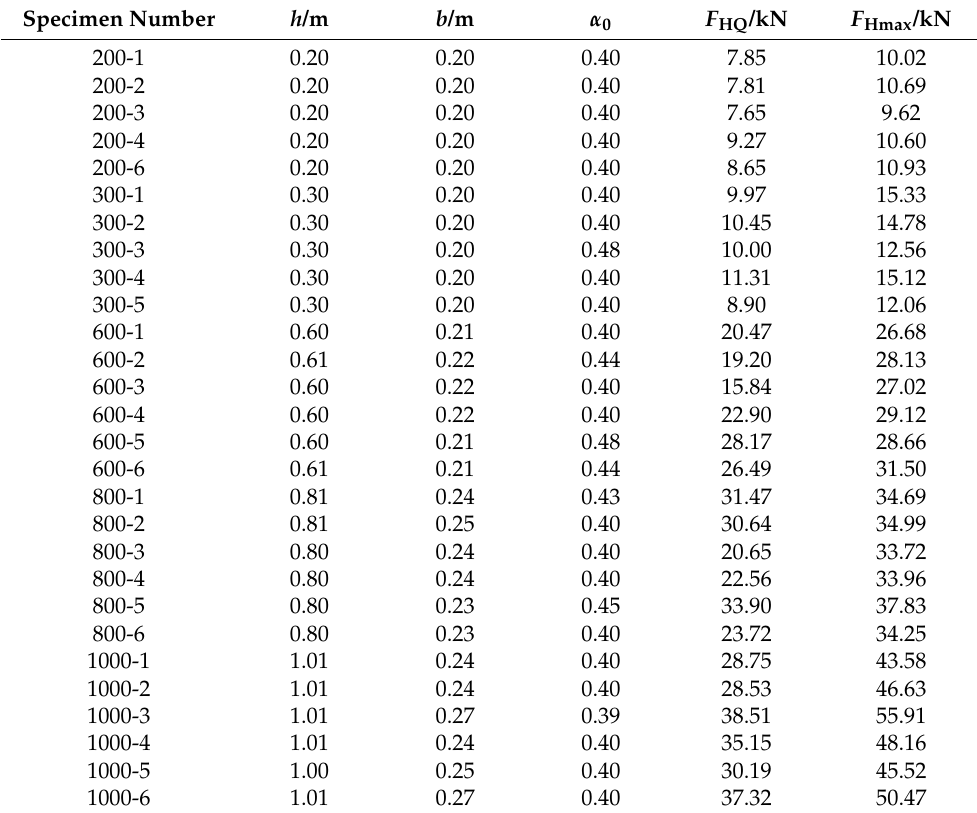
Table 1. Fracture test results reported in reference